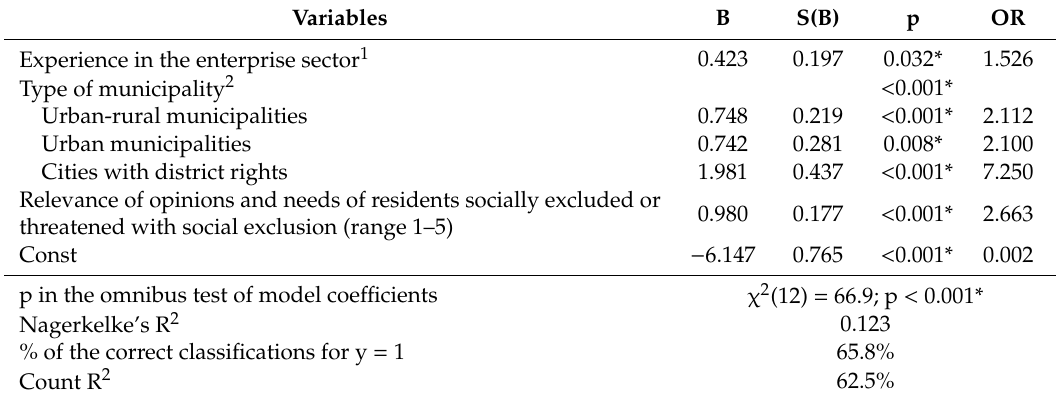
Table 7. Determinants of holistic smart and age-friendly approach—logistic regression